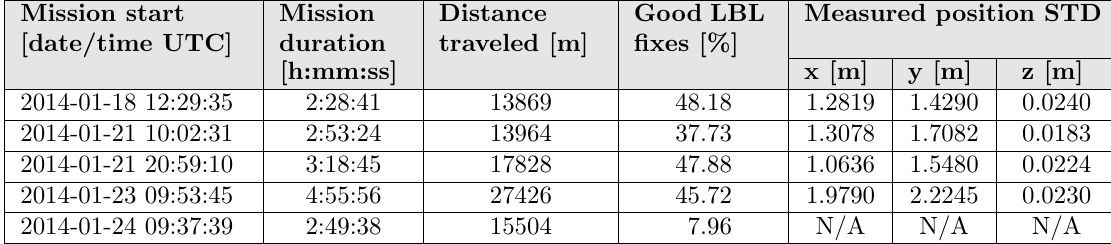
Table 2: REMUS mission statistics. Mission duration, distance traveled, and percentage good LBL fixes reported by the REMUS VIP, made by Hydroid. Standard deviations calculated by the NavLab software (Gade, 2004). NavP data was not available for the cross-fjord survey